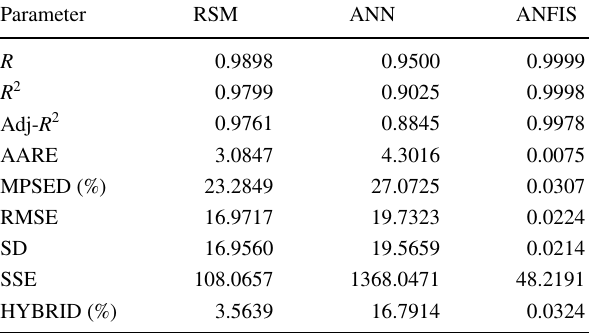
Table 7 Statistical appraisal of RSM, ANN and